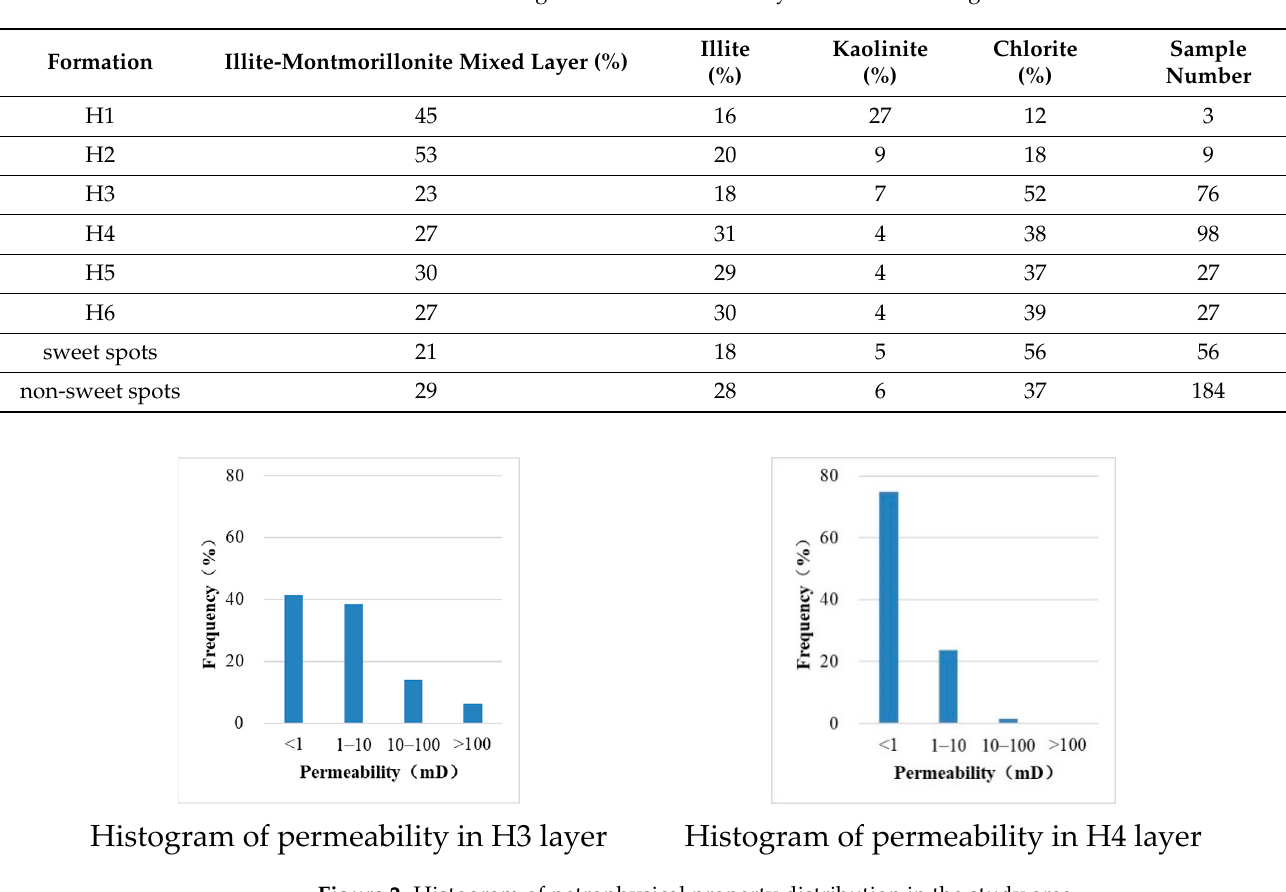
( c ) Figure 3. Correlation between main clay minerals of the X gas field and their relationship with petrophysical properties. ( a ) Correlation between relative content of clay minerals and permeability; ( b ) Correlation between relative content of I-M mixed layer and Chlorite; ( c ) Correlation between relative content of Illite and Chlorite. The chlorite in the study area has complete crystal shape, clear edges and high purity of composition. Authigenic chlorite is identified according to its microscopic and occur- rence characteristics. The above analysis shows that the authigenic chlorite in this area is closely related to the sweet spots and plays a positive role in improving the petrophysical properties of reservoirs.